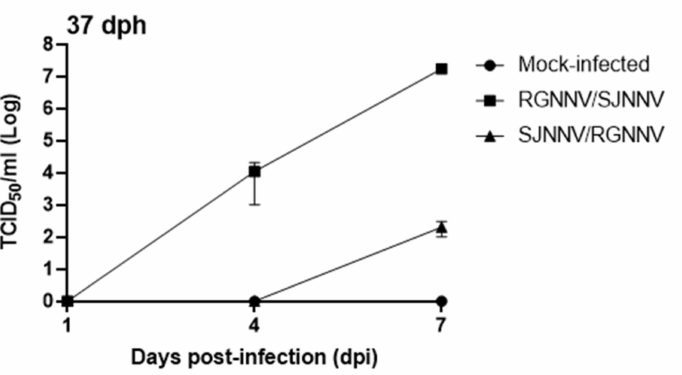
Figure 3. Infective nodavirus (NNV) particles are isolated from seabream larvae. Seabream larvae at 37 days post-hatching (dph) were infected by immersion with 10 4 TCDI 50 / mL of RGNNV/SJNNV or SJNNV/RGNNV reassortants. The control was a mock-infected group. At 1, 4 or 7 days post- infection (dpi) pooled whole larvae ( n = 3) were homogenized and the viral titer determined in E-11 cell cultures. Data are shown as mean titer ±